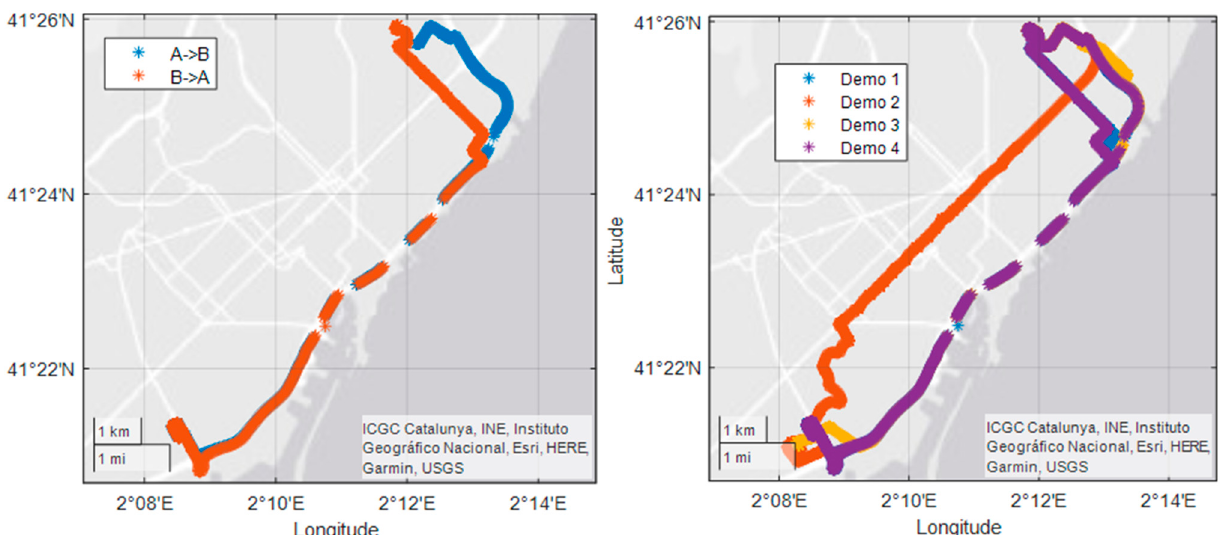
Figure A2. Route map of N5 for the demonstration. Appendix A.3. Gothenburg City